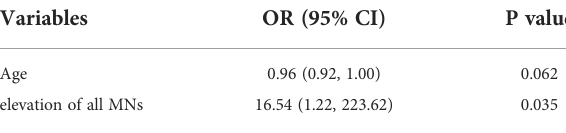
TABLE 3 Results of multivariate